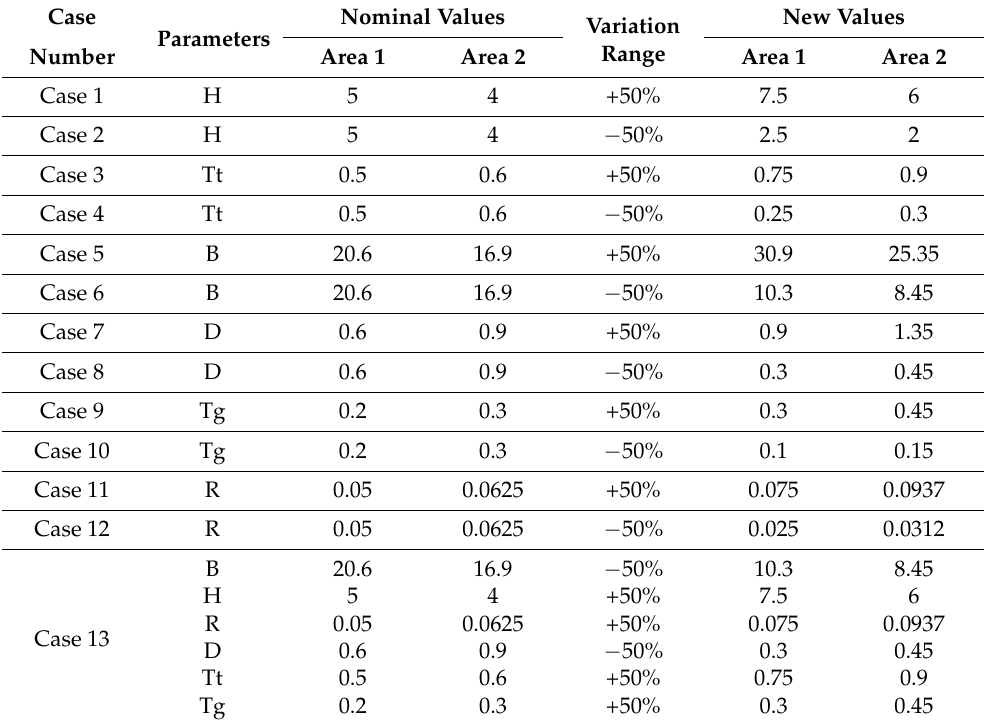
Table 11. Investigated scenarios of system parametric